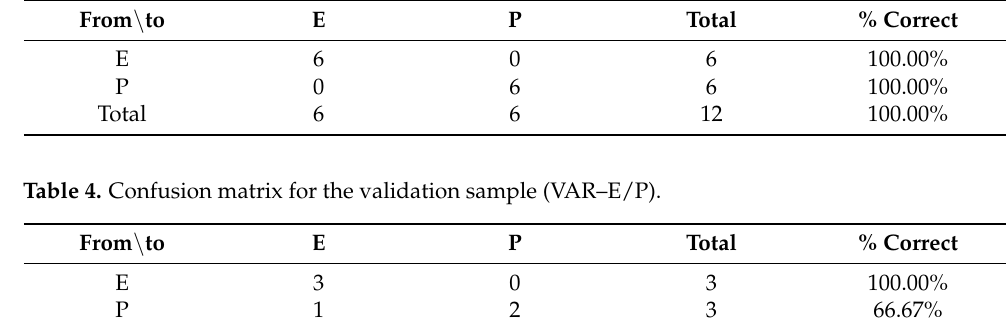
Table 3. Confusion matrix for the training sample (VAR–E/P).